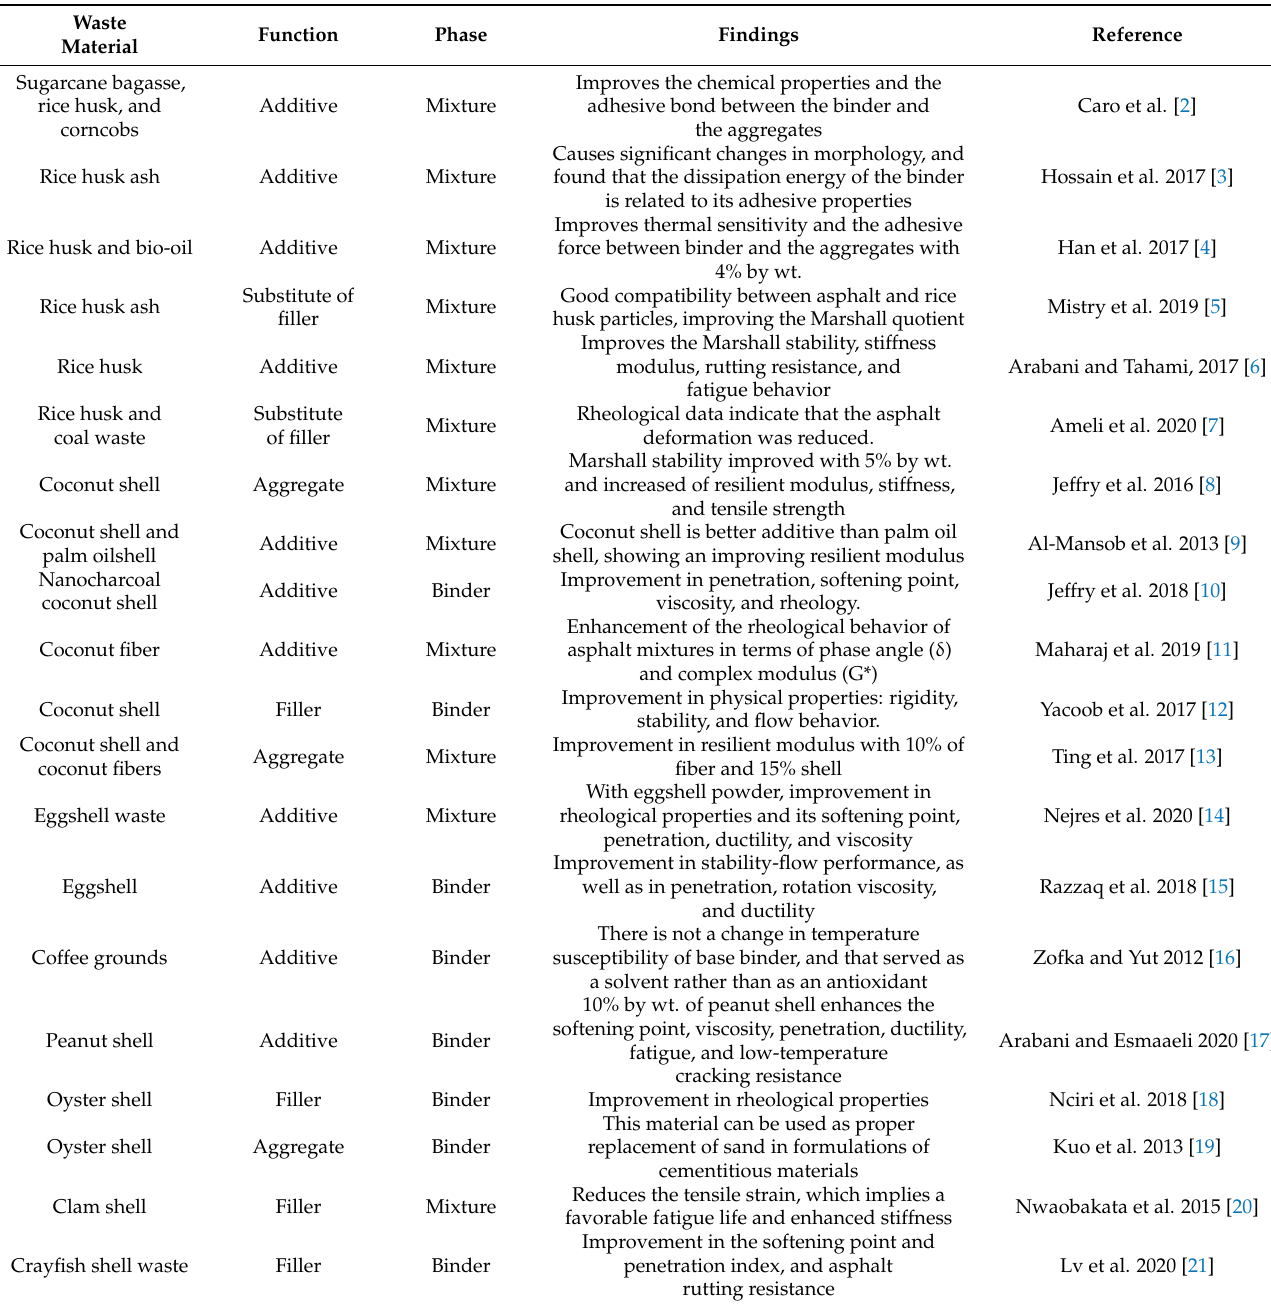
Table 1. Different types of waste material used in asphalt